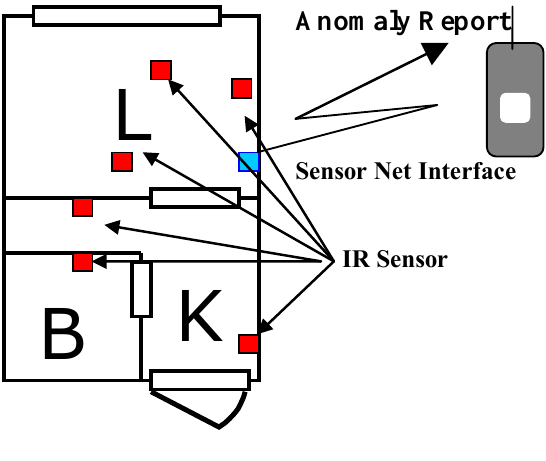
Figure 4. Layout of sensors in a room for the experiment. (K: kitchen, L: living room, B: